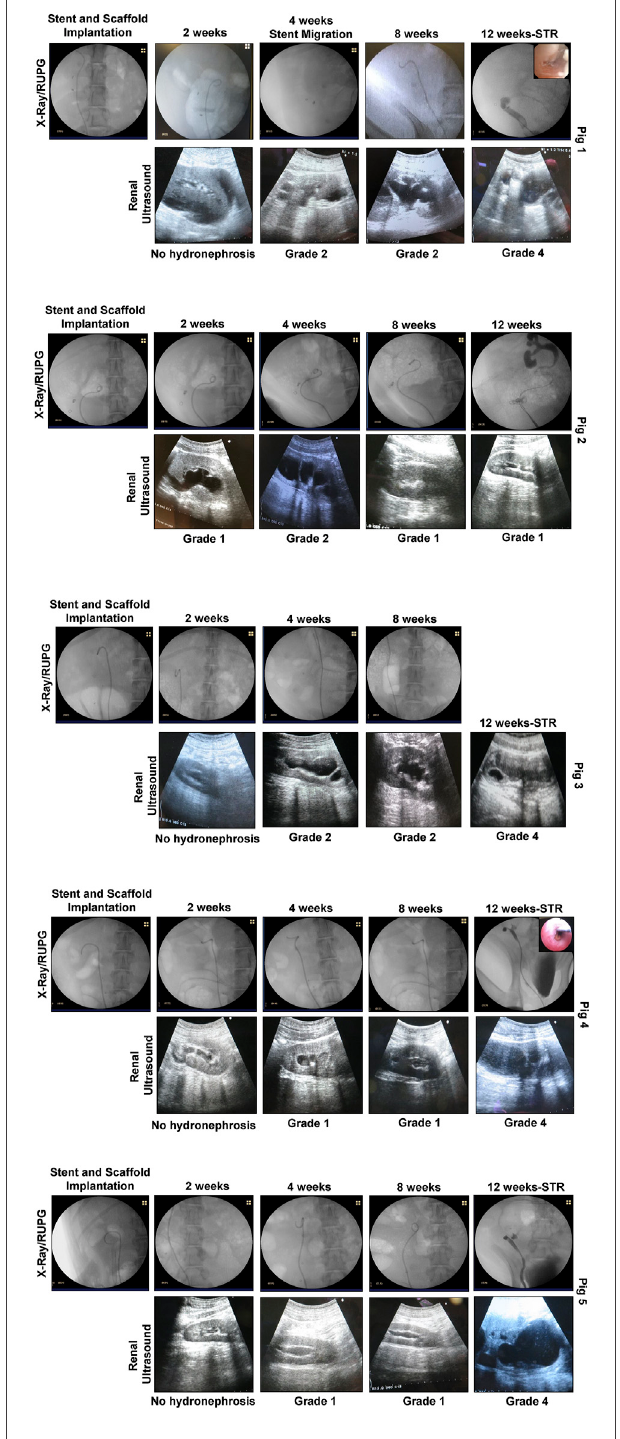
FIGURE 2 | In situ imaging evaluations of reconstructed ureteral conduits. Representative data for Pigs 1 – 5. Ureters were implanted with stented, tubular BLSF matrices. Stents were removed at 8 weeks post-op and swine were harvested at 3 months. In the majority of swine, severe Grade 4 hydronephrosis and neotissue stricture formation were detected in operated ureters at sacri fi ce. X-Ray (2, 4, 8 weeks) and contrast RUPG